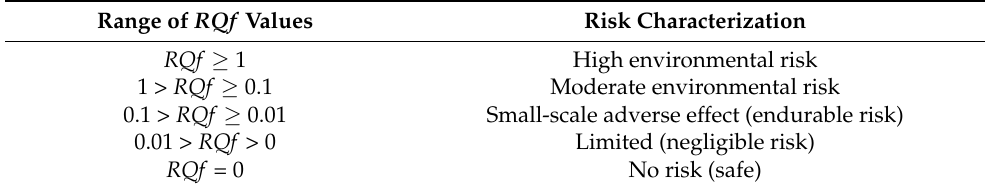
Table 4. Characterization of risks based on the frequency-based risk